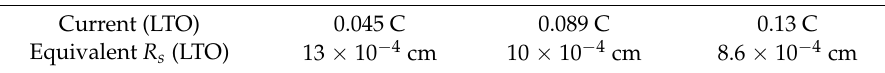
Table 3. Adjusted particle size for LTO anode at different C rates.